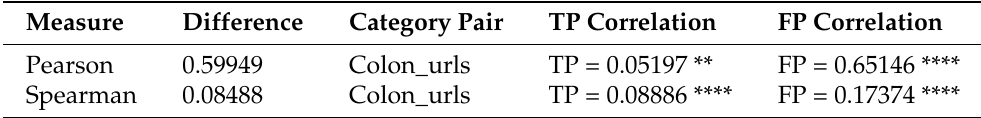
Table 54. Colons and Urls in Suicidal.